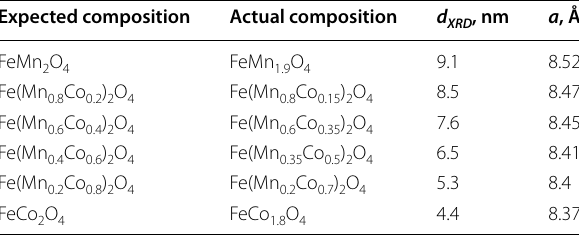
Table 2 The actual compositions obtained from the results of ICP‑MS, the average crystallite sizes calculated by the Scherrer equation ( d ), and lattice constants ( a ) of the Co‑doped XRD FeMn O nanoparticles 2 4 Expected